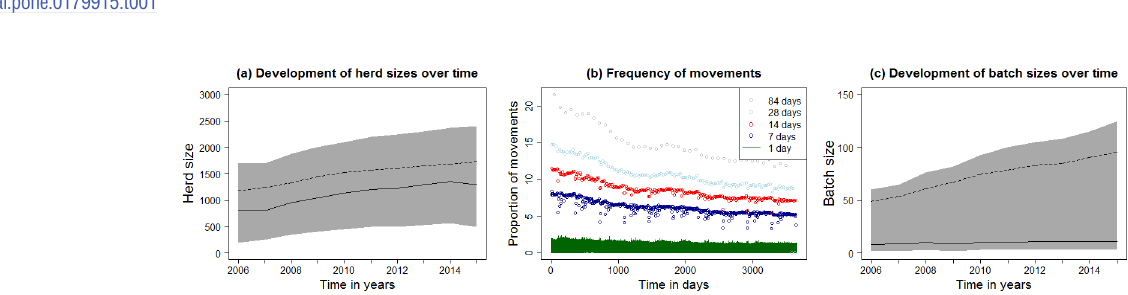
Fig 2. Descriptivestatistics of the examined data. Figure (a) and (c) show the median(solid black line) and average(dashedblack line) of holdingsizes and of the numberof pigs moved per pig movement sizes over time. Grey areas represent the range between1 st and 3 rd quantile.Temporal trends of holdingsizes for the investigated24 holdingtypes are shown in S1 File. Figure (b) shows the proportionof registered pig movementsout of all possiblemovementsin Denmark between1 st January 2006 and 31 st December 2015 on daily base (green)and aggregatedfor 7 (dark blue), 14 (red), 28 (light blue) and 84 (grey)